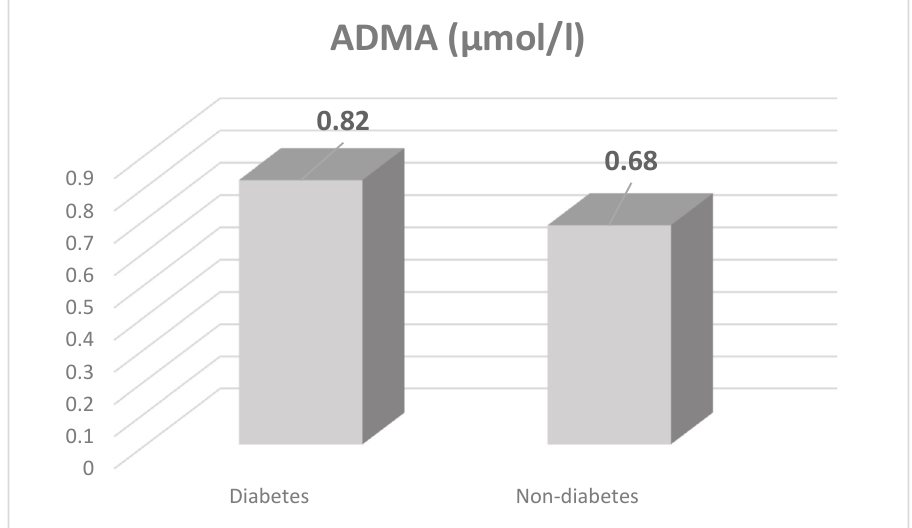
Figure 3. ADMA concentration in KTRs with and without diabetes mellitus ( p < 0.05).